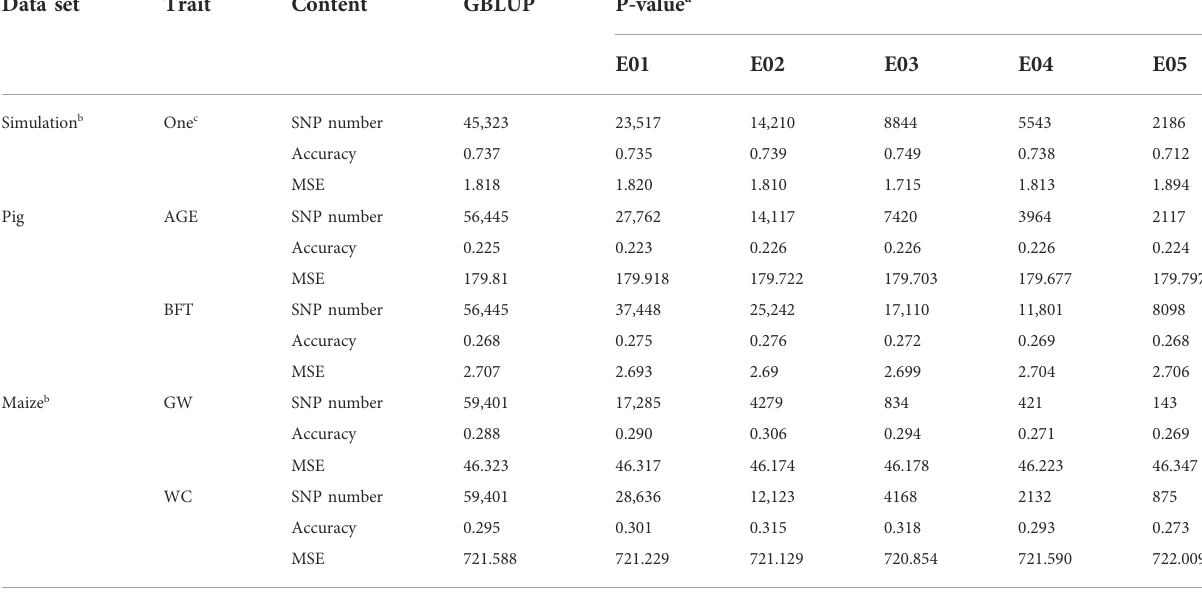
TABLE 3 Genomic prediction accuracies and mean squared error (MSE) for GBLUP and G × EBLUP method under different G × E interaction p -values (E01~E05). Data